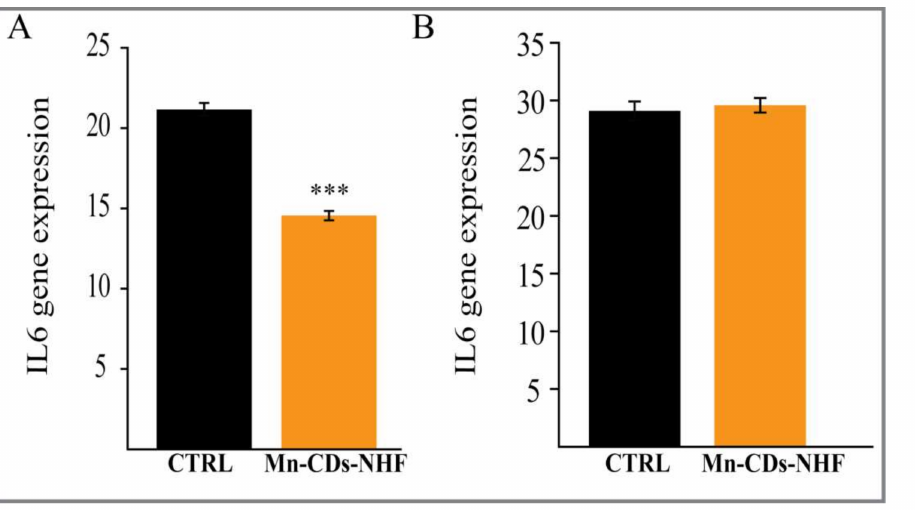
Figure 8. IL-6 mRNA expression in cell culture ( A ) and murine lung samples ( B ) *** p <